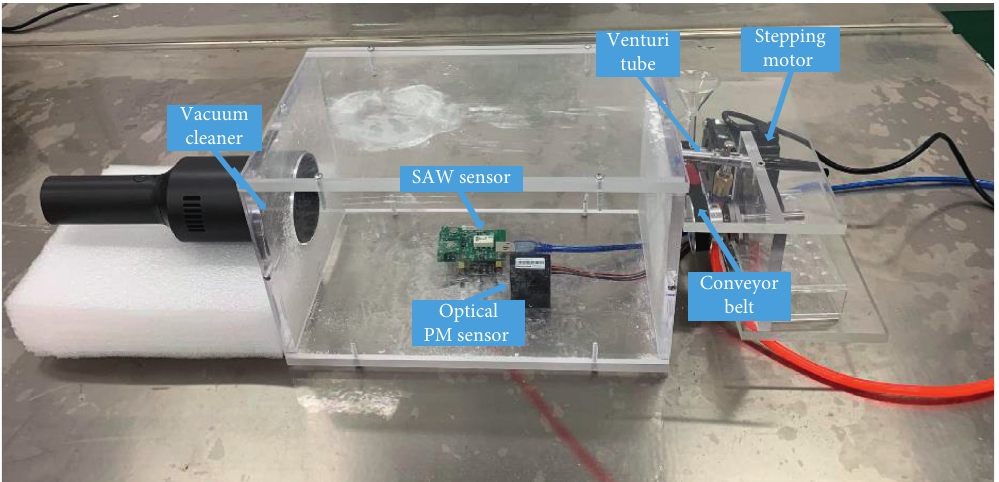
Figure 7: The setup of the 7L PM test platform.